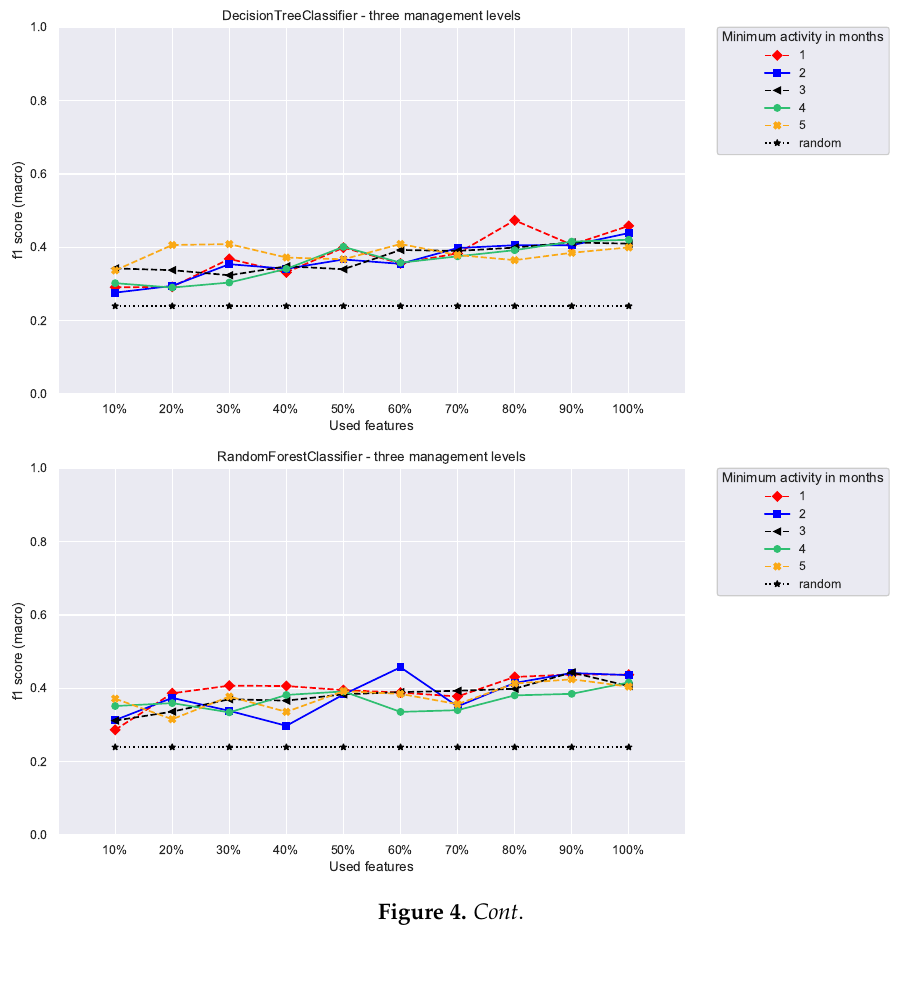
Figure 3. The result of the classification of two groups for the manufacturing company dataset.